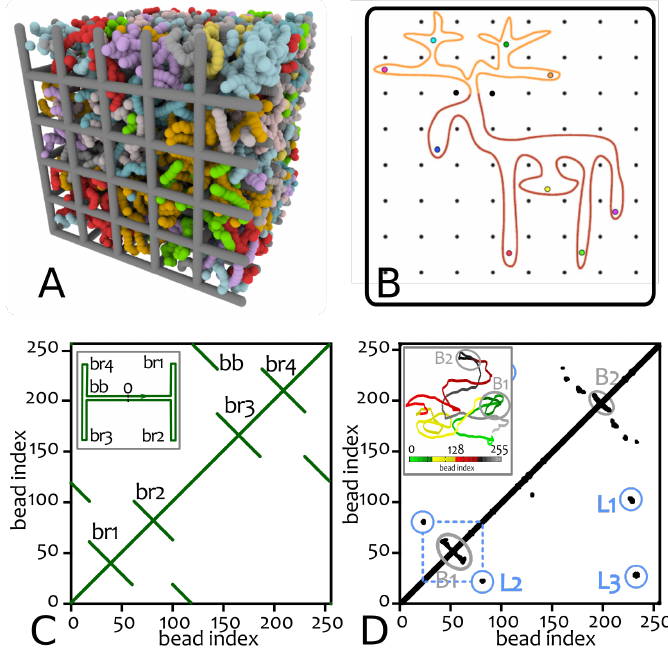
Figure 2. Rings as “loose” lattice animals. ( A ) Snapshot from Molecular Dynamics simulation representing the dense solution of rings contained within a background mesh of static obstacles reminiscent of an idealised agarose gel. ( B ) A possible configuration of an isolated ring, assuming a so-called “lattice animal” [23] (an elk, in this case) state (adapted from Reference [24]). Each black dot represents a un-crossable obstacle, i.e., either a strand of the gel or a neighbouring ring that is not threading through the contour of the animal. Coloured circles instead represent ingoing and outgoing threading sites. ( C ) Contact map for an ideal lattice animal (sketched in the inset). Notice the sole presence of lines capturing the tightly double-folded nature of the animal. ( D ) Contact map for a ring polymer in a dense solution (3D configuration reported in the inset and colour coded as per bead index, adapted from Reference [25]). Notice that the real diagram shows the presence of spots rather than lines, indicating the existence of long-range loops (e.g., L1, spanning about half contour length), which are good candidate structures to accommodate